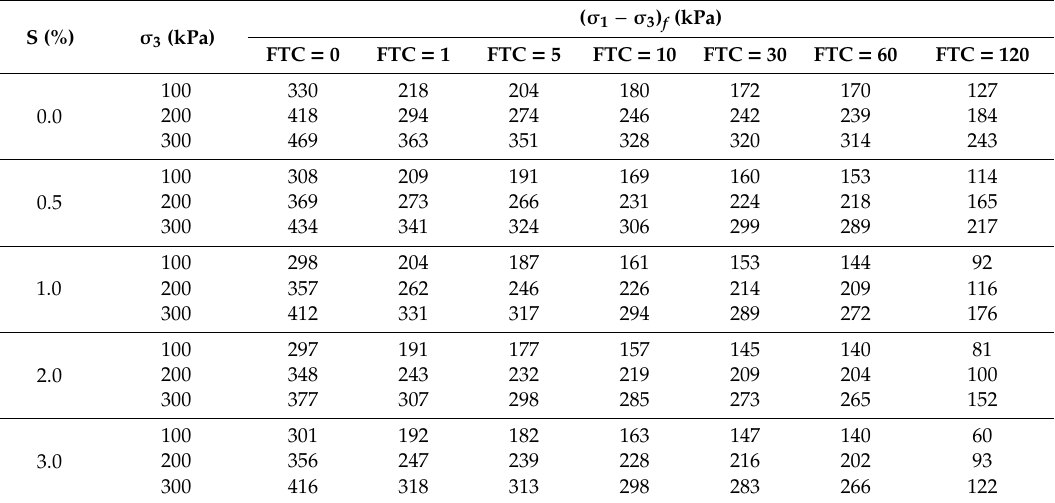
Table 2. Failure principal-stress deviation ( σ 1 − σ 3 ) f of samples.